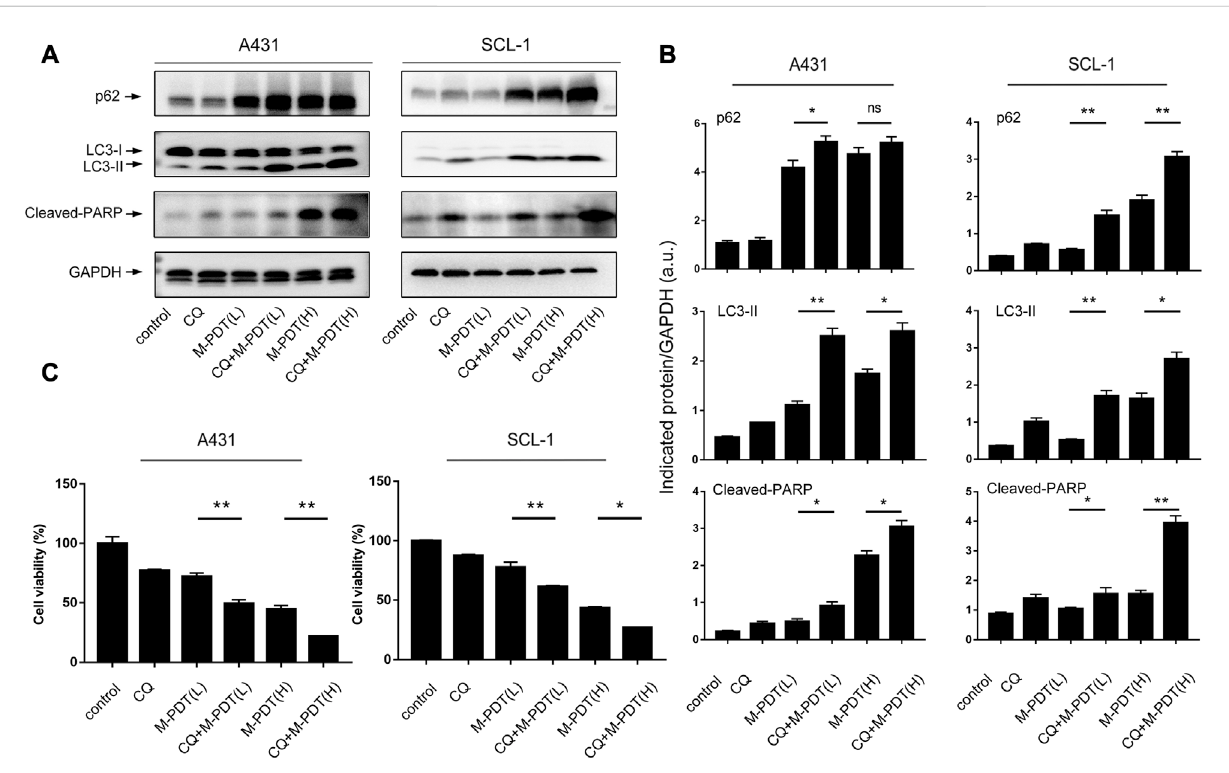
FIGURE 4 CQ potentiates M-PDT-inducedautophagic fl ux blockage and cSCC cell viabilitysuppression. (A) Westernblot for indicated antibodies. GAPDH isa loading control. (B) The blots for LC3-II, p62, and Cleaved-PARP were semi-quanti fi ed. (C) Cell viability was detected by CCK8. M-PDT (L) stands for low dose M-PDT, and M-PDT (H) stands for high dose M-PDT. * p < 0.05, ** p < 0.01. n =